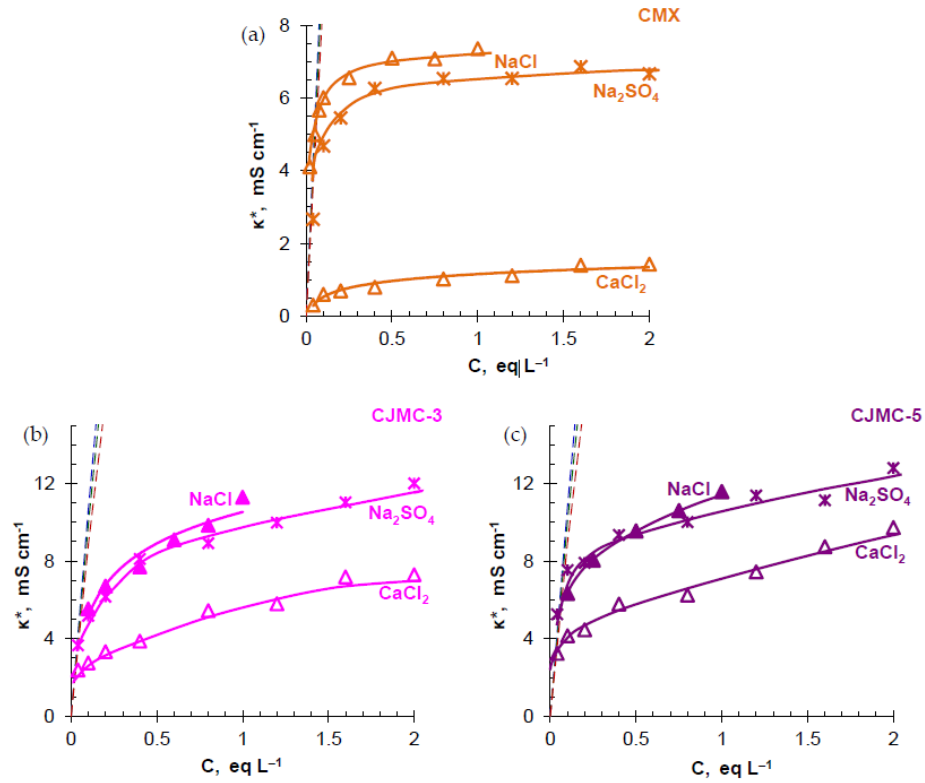
Figure 4. Electrical conductivity of CMX ( a ), CJMC-3 ( b ), and CJMC-5 ( c ) membranes vs. concentration of NaCl, CaCl 2 , and Na 2 SO 4 in the external solution. The dashed line shows the concentration dependence of the NaCl (blue), Na 2 SO 4 (red), CaCl 2 (green) solution conductivity. The continuous lines are for the guide of eyes.